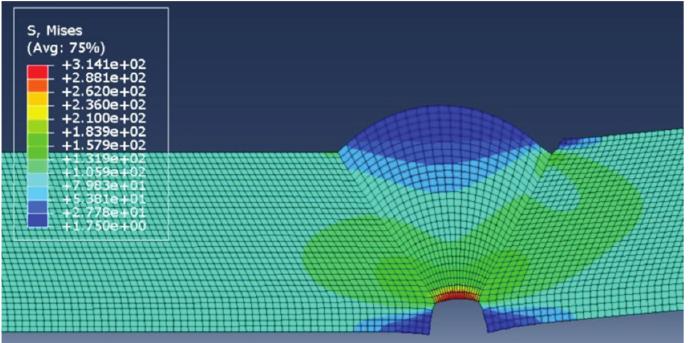
Figure 9. Result for vertical misalignment, undercut, and slight excess root penetration.